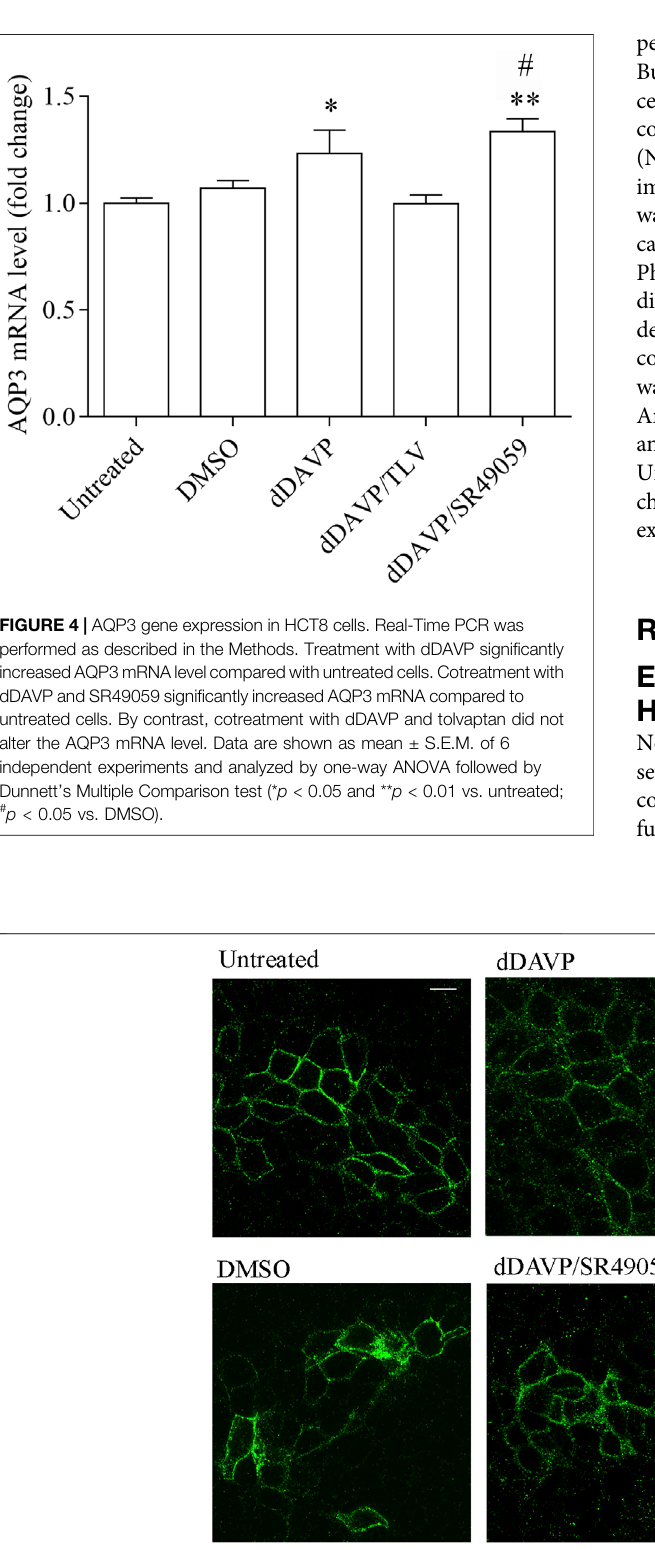
Frontiers in Cell and Developmental Biology |